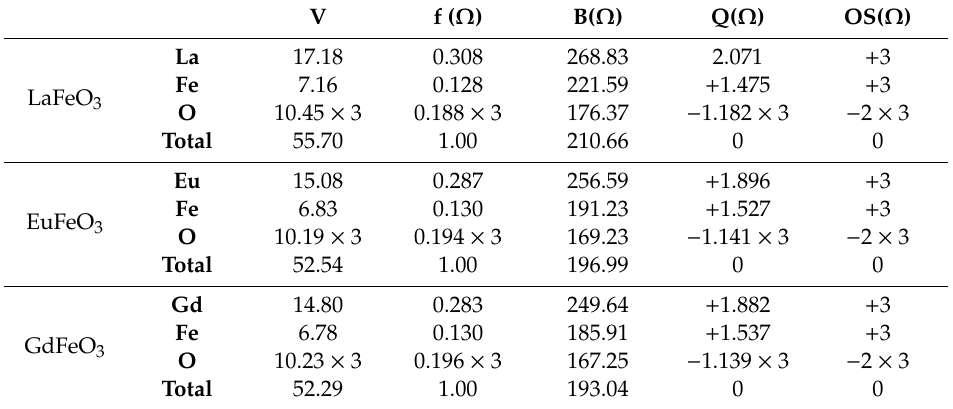
Table 6. The topological charges (Q), volume of each basin, and C index of RFeO 3 (R = La, Eu, Gd). V f ( Ω